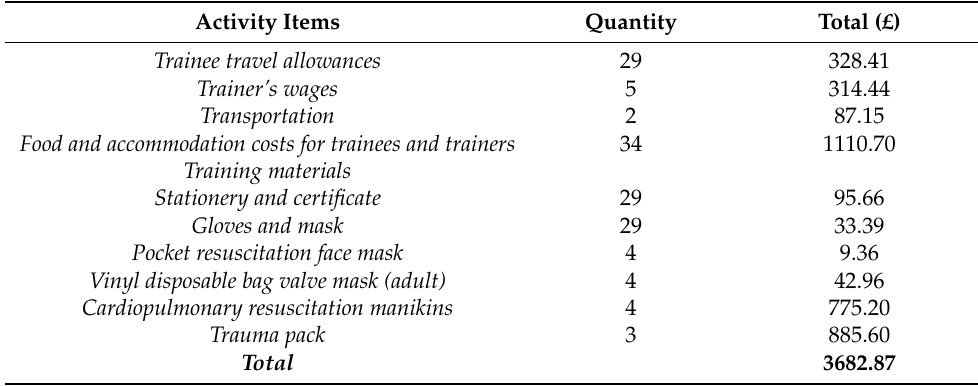
Table 4. First responder training program